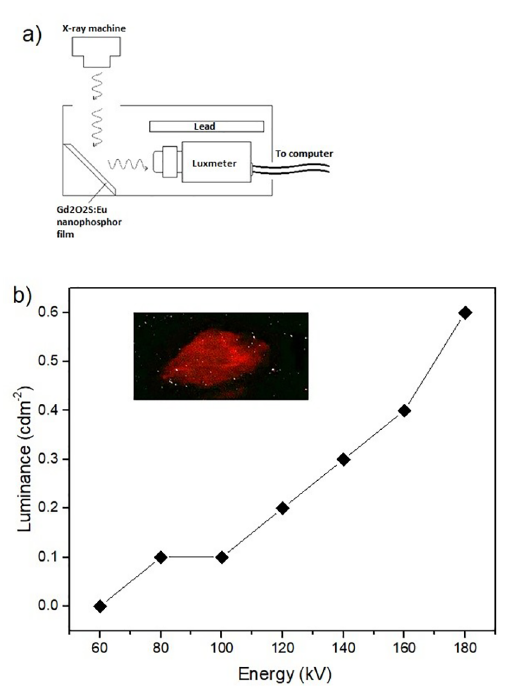
Figure 5. (a) Experimental setup for light output measurement and b) the light output of the Gd mA and 60, 80, 100, 120, 140, 160 and 180 kV( inset is film image under x-ray